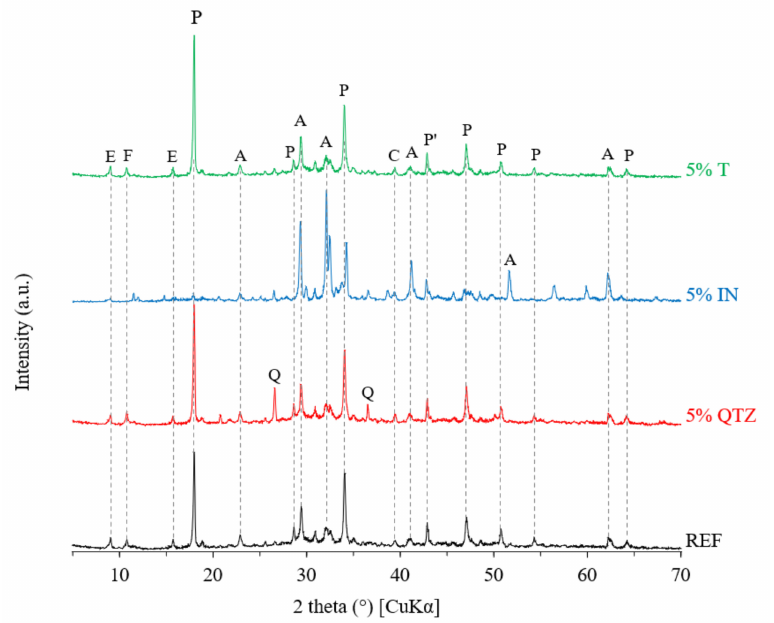
Figure 6. Isothermal calorimetry curves of the pastes up to 160 h: ( a ) heat flow; ( b ) cumulative heat. Note: IN = in natura, S = saturated; T = treated; QTZ = quartz.